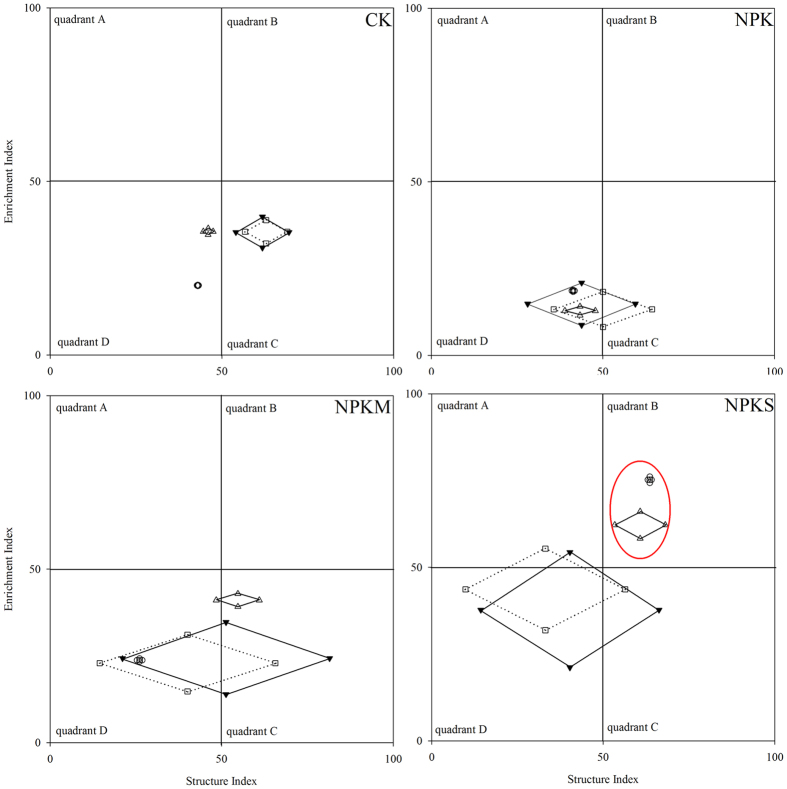
Functional metabolic footprint of nematodes subjected to fertilization in the wheat season (▾, ◻, ∆, ⚪ represent >2 mm, 1–2 mm, 0.25–1 mm and <0.25 mm, respectively).The vertical axis and horizontal axis of each footprint represent the enrichment footprint and structure footprint, respectively. The functional metabolic footprint is described by the sequentially joining points: (SI-0.5Fs/k, EI); (SI, EI + 0.5Fe/k); (SI + 0.5Fs/k, EI); (SI, EI-0.5Fe/k). Fs and Fe represent the structure footprint and enrichment footprint, respectively. EI and SI represent enrichment index and structure index, respectively, and the k value is 3. The nematode functional metabolic footprint is the total area of the two functional (enrichment and structure) footprints4656.